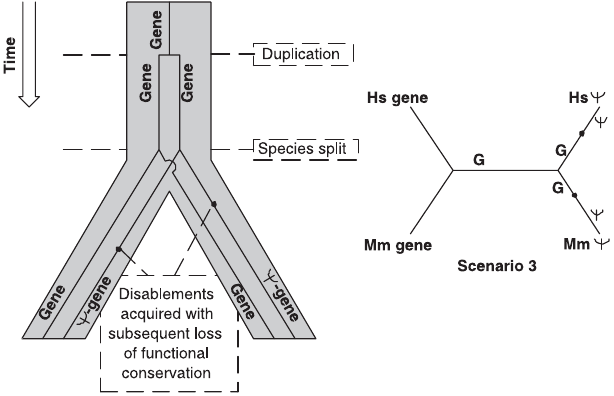
Figure 3. Evolutionary Scenario S 3, Describing Independent Transitions DOI: 10.1371/journal.pcbi.0020046.g003